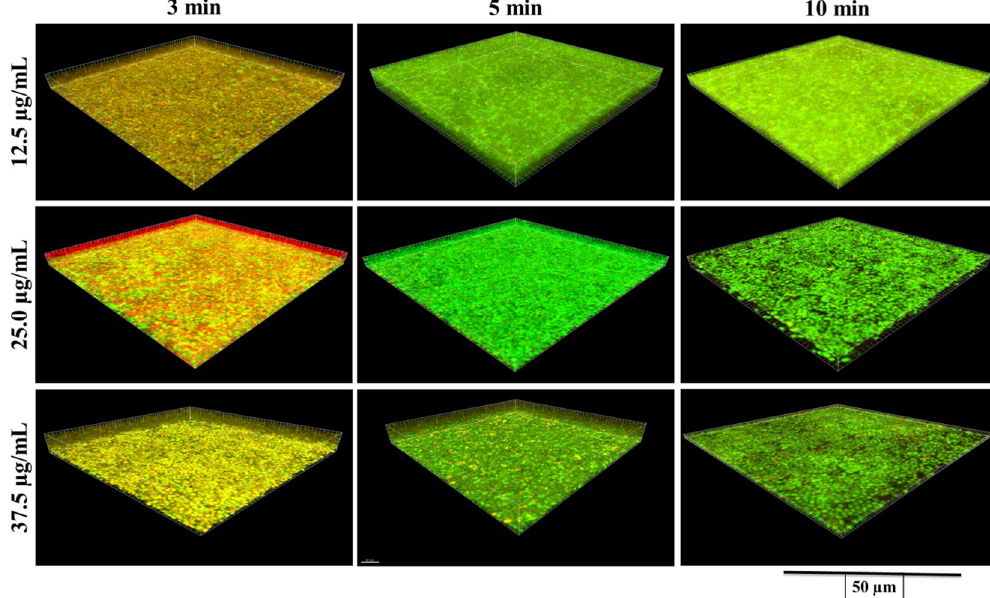
Figure 4. CLSM image of 48 h biofilms after treatment with different concentrations of DMAHDM for 3 min, 5 min and 10 min.